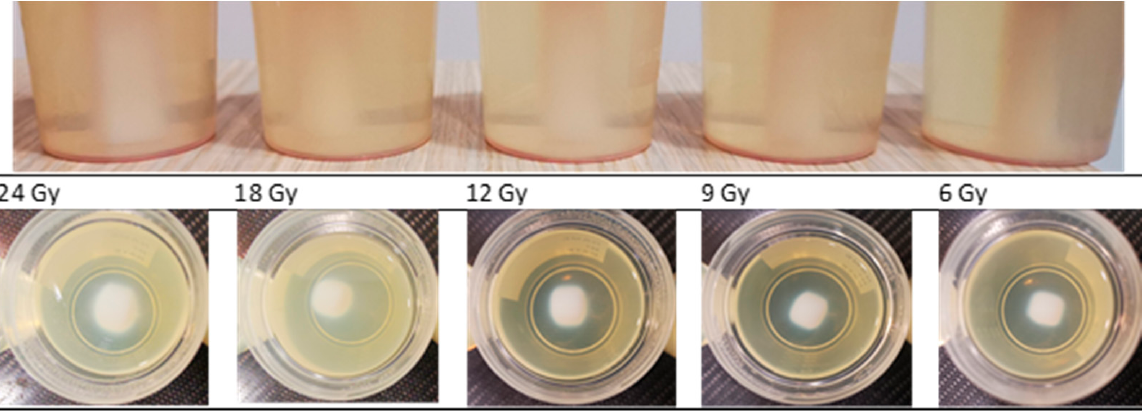
Figure 1. Photographs of nMAG gels irradiated with various doses applying small field beam irradiation geometry (photographs were taken just after the irradiation).